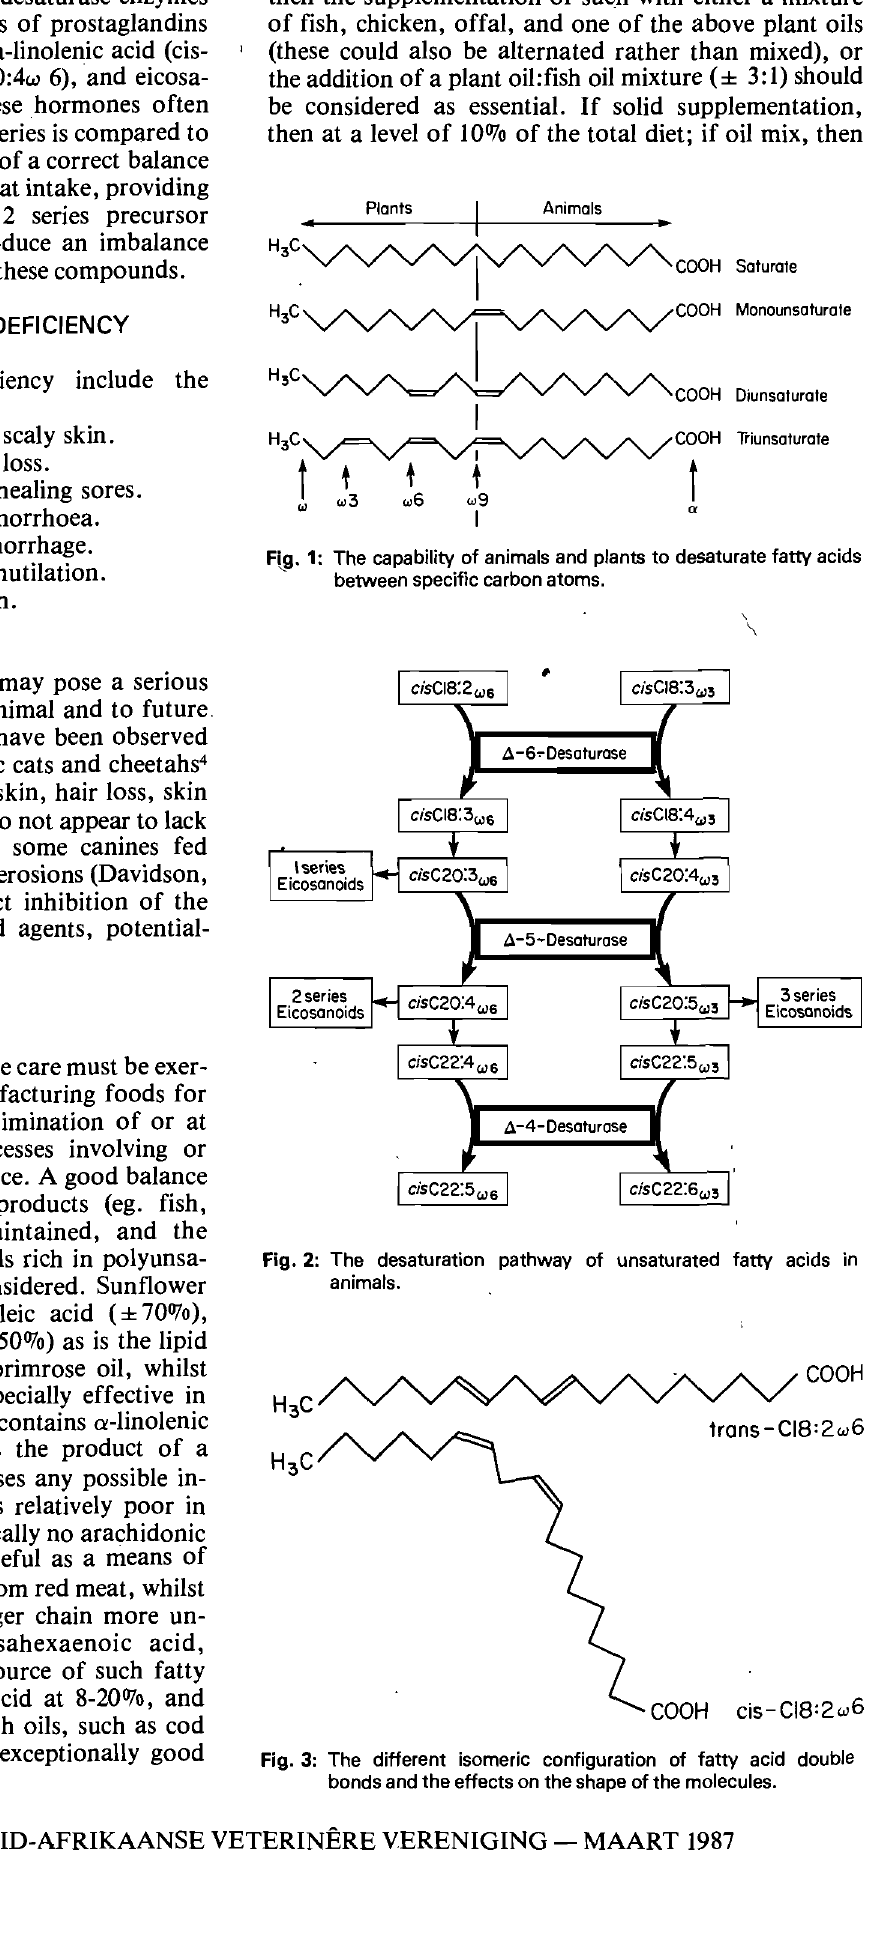
Fig. 1: The capability of animals and plants to desaturate fatty acids ~ between specific carbon atoms.